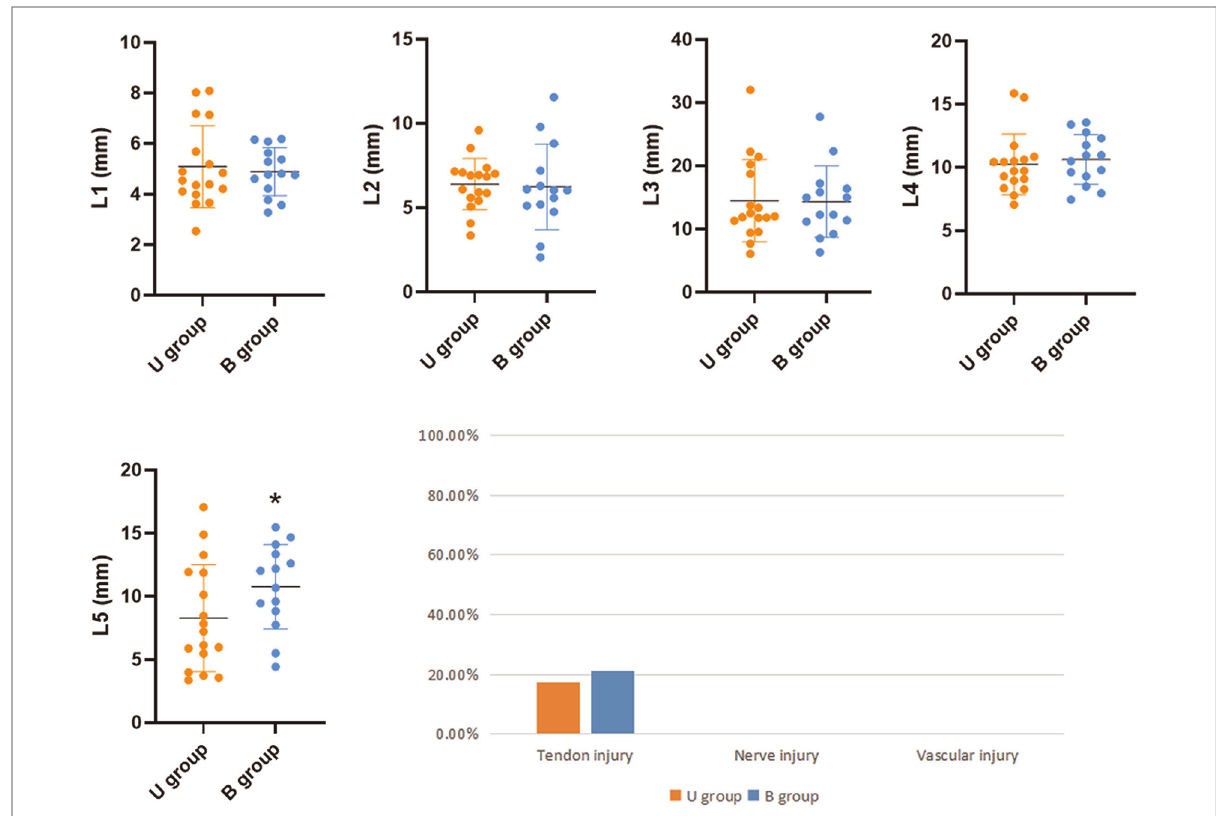
FIGURE 6 Distance of the incision from nerves and blood vessels and injury